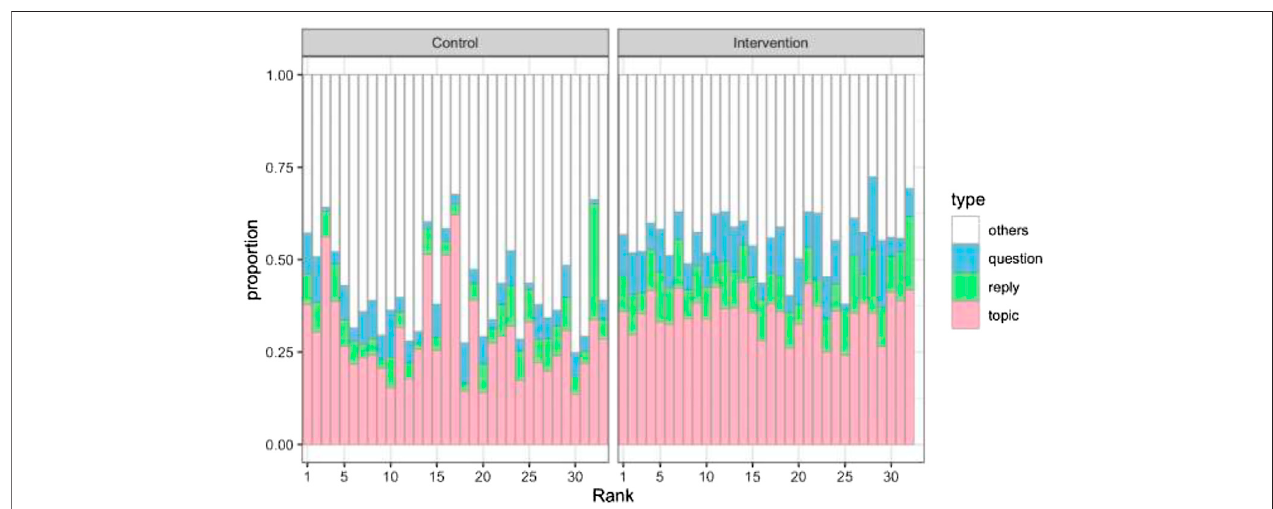
FIGURE6| Thepercent stackedbar plotfor four types ofutterances.The horizontal axis stands forthe rankorder ofthetotal number ofutterances (the person on the left has the most utterances and the person on the right has the least) within the control and intervention groups.